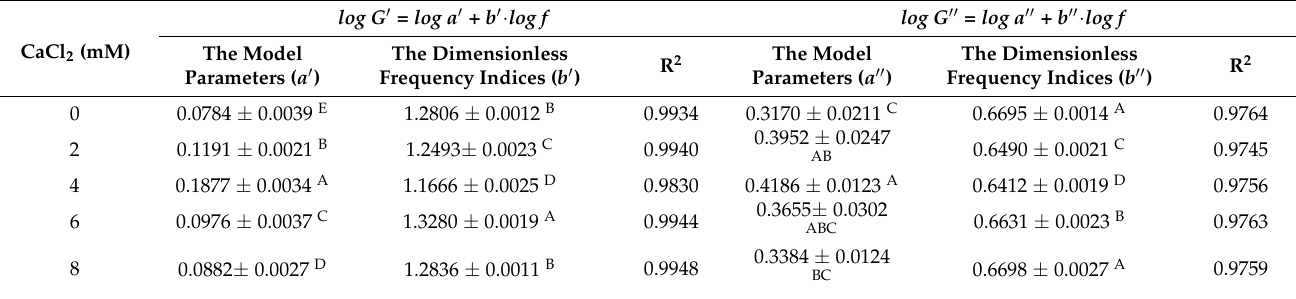
Figure 2. Apparent viscosity of the freshly prepared filled hydrogels containing different calcium chloride (CaCl 2 ) levels. Table 4. Frequency sweep of the storage moduli ( G (cid:48) ) and loss moduli ( G (cid:48)(cid:48) ) of the freshly prepared filled hydrogels containing different CaCl 2 levels using the power law